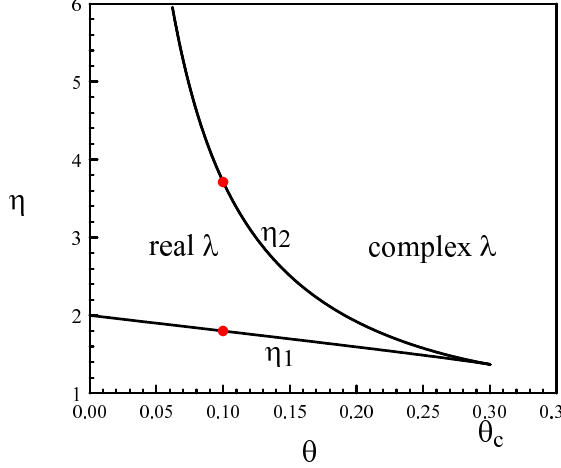
Figure 3. Domain in the ( θ , η ) parameter space for negative real roots of the characteristic Equation (7). The red dots at θ = 0.1 correspond to the limit points of the S-shaped curve in Figure